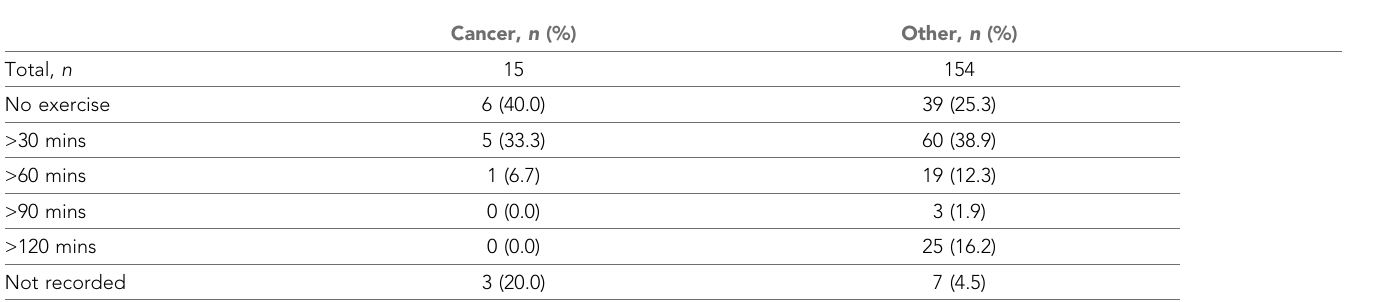
Table 2. Details of levels of exercise related to diagnosis